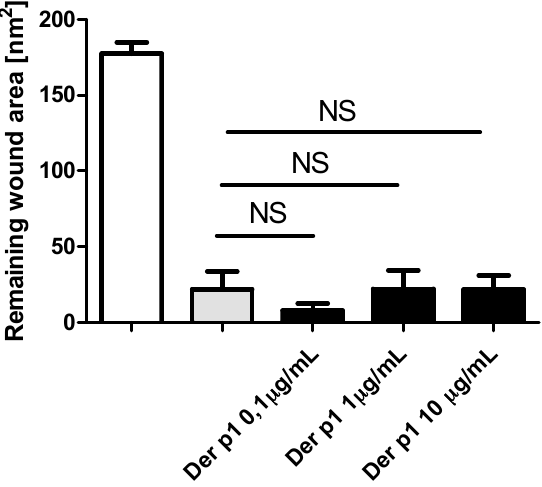
Figure 4. Effect of Der p1 on wound repair in BEAS-2B ( n = 6 for 1 µ g/mL, n = 4 for 0.1 and 10 µ g/mL), 24 h post injury. NS: no statistically significant